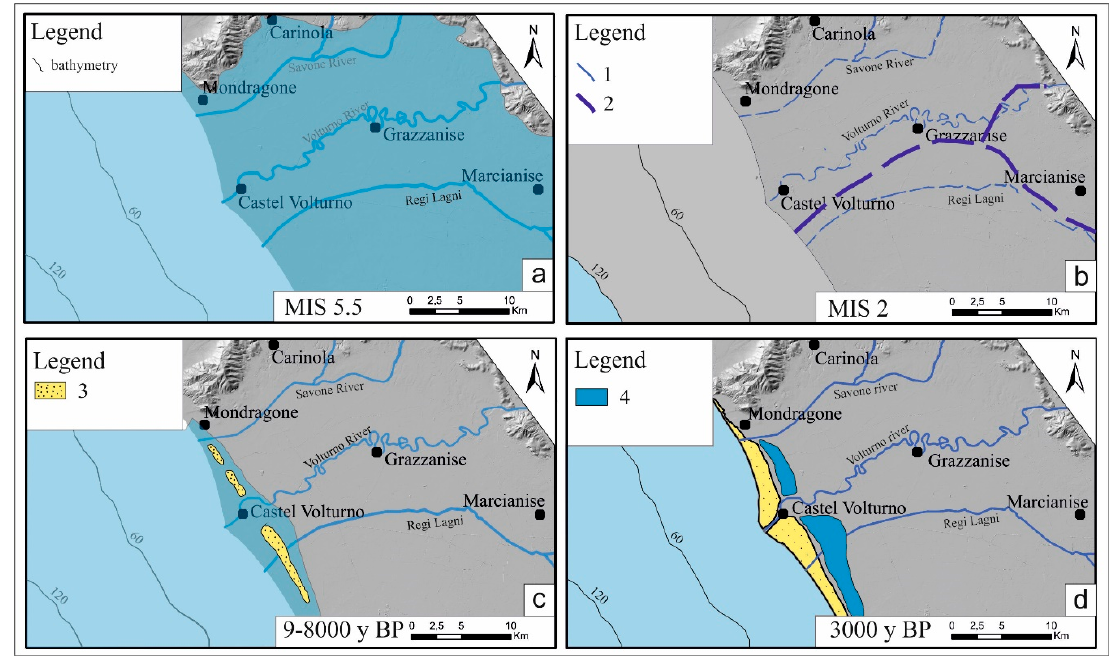
Figure 8. Morpho-evolutive stages (see text for explanation). Legends: (1) Current rivers; (2) Paleo- Volturno course; (3) dunal ridge; (4) swamp.